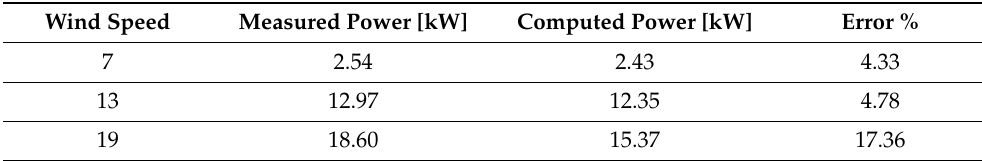
Table 4. Comparison of measured and computed power production.